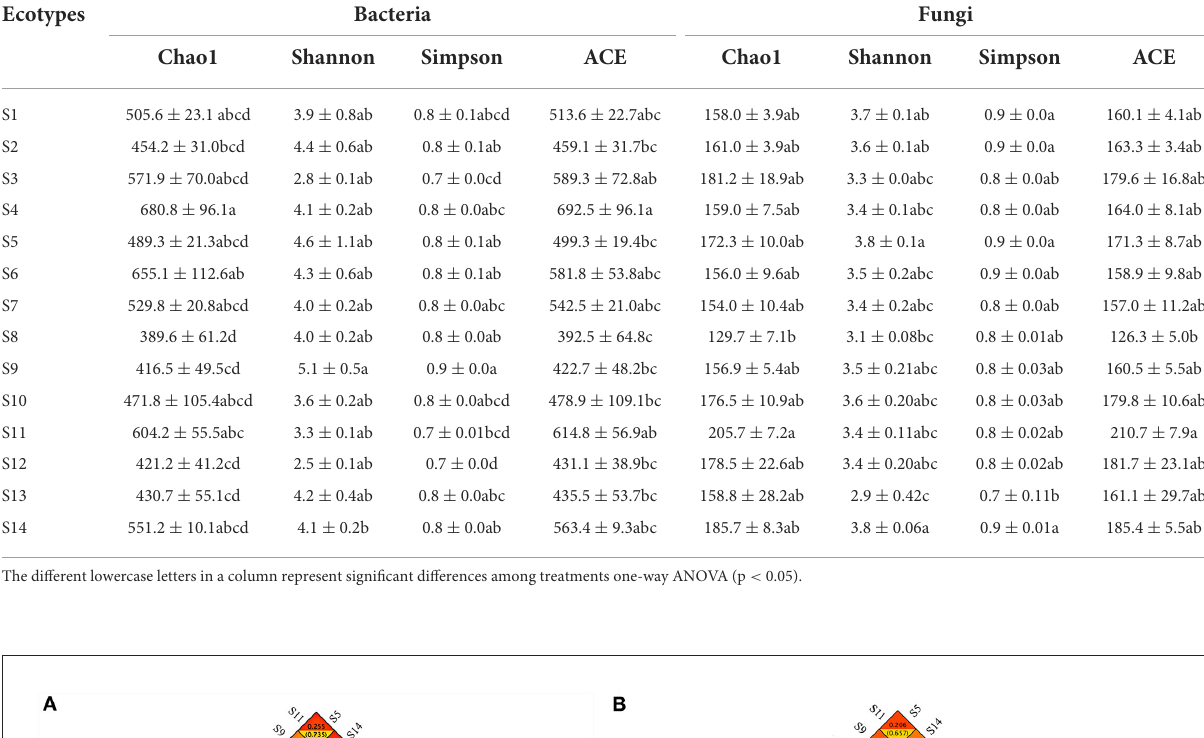
TABLE 2 α -diversity of bacterial and fungal communities in seeds.